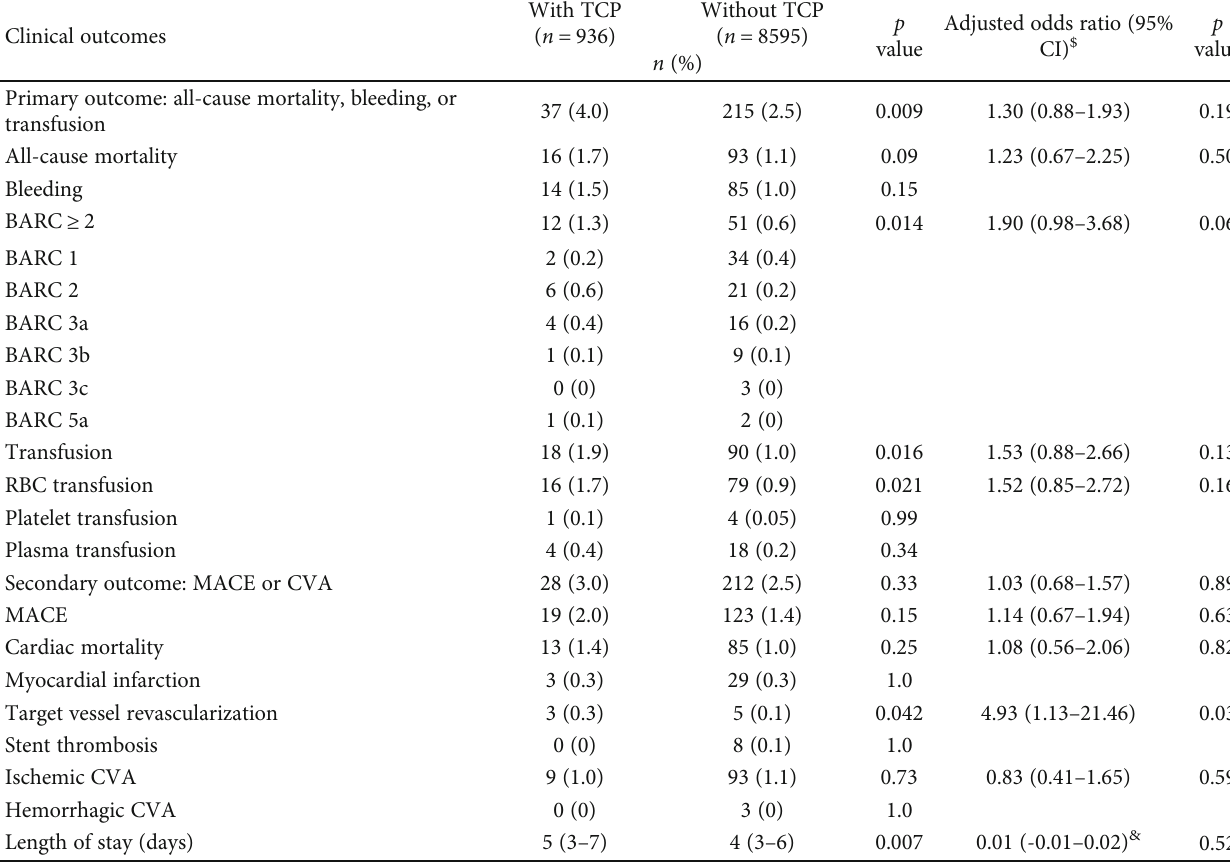
Table 2: The association between thrombocytopenia and the occurrence of clinical outcomes.